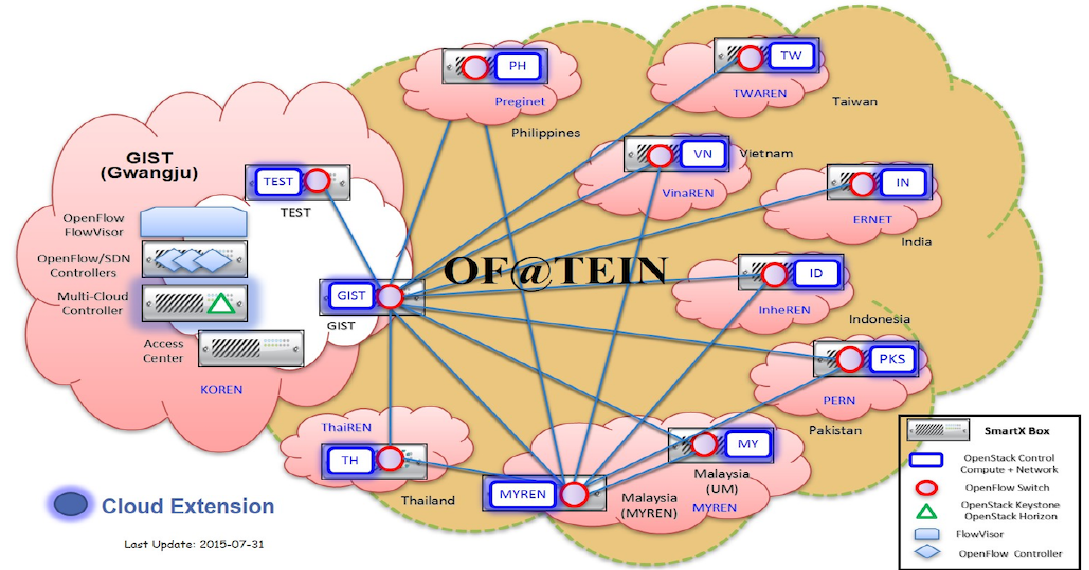
Figure 13. OpenStack Multi-Regional Configuration in OF@TEIN